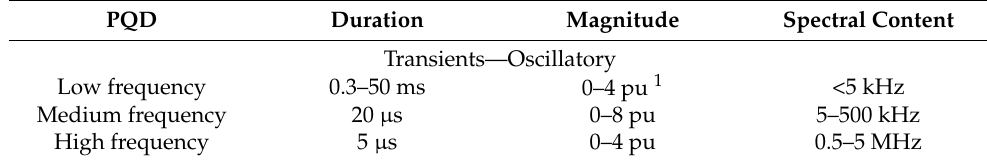
Table 2. Fragment of the PQD classification according to IEEE-1159 standard [38].